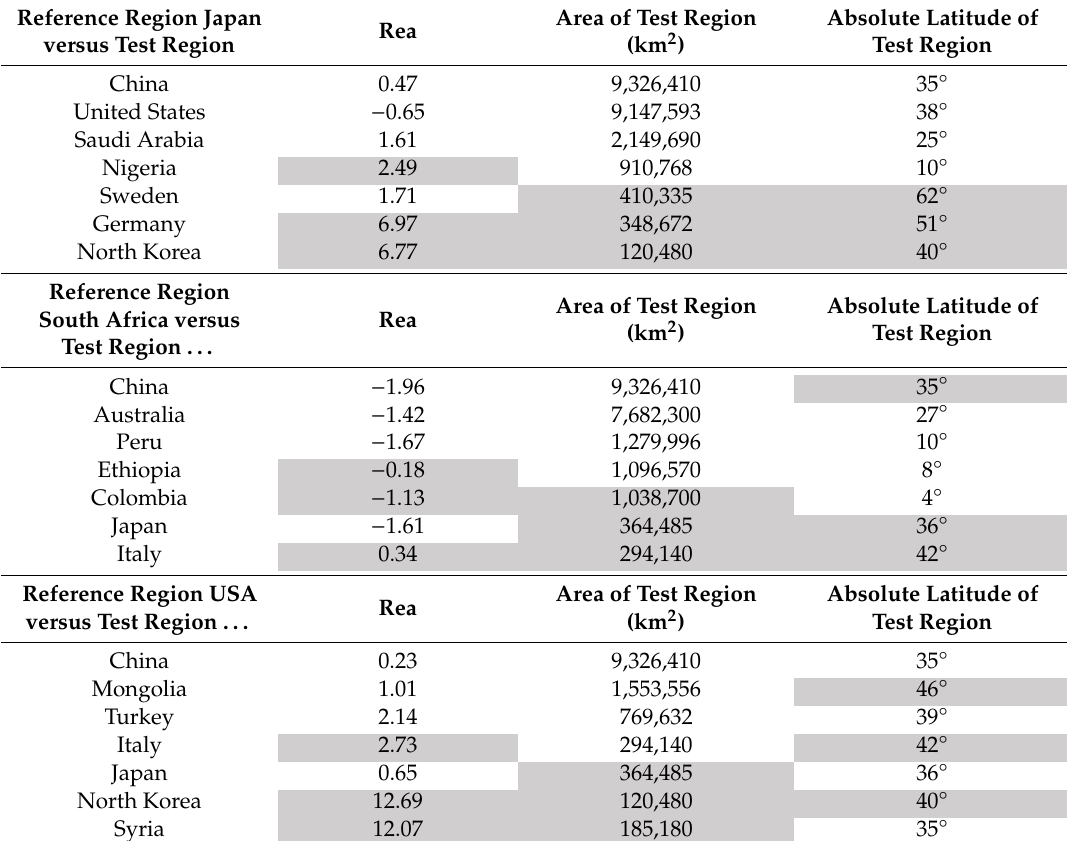
Table 10. Three reference regions (Japan, South Africa, USA) compared to certain test regions (with area as size of the country in km 2 , latitude, and rea as the average of the relative estimated accuracy values for that particular test region), grey = least accurate estimations, smallest countries, and highest